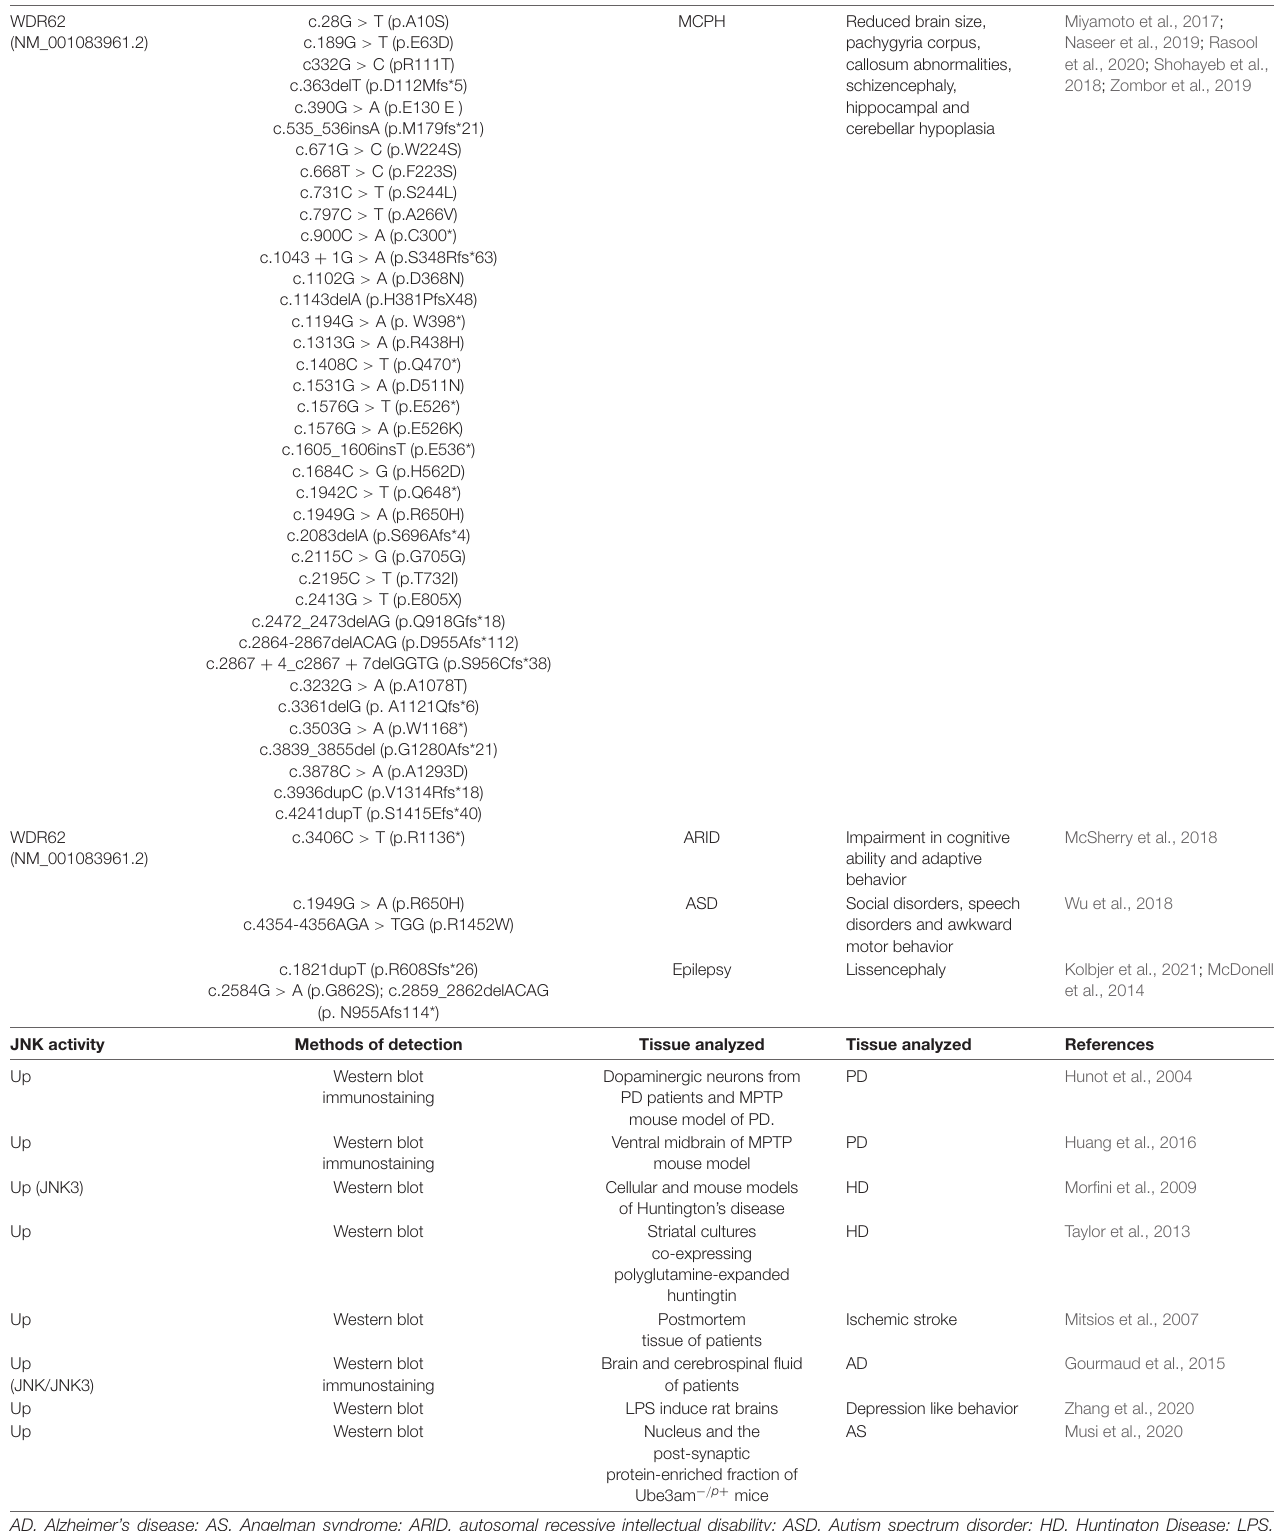
TABLE 1 | WDR62 and JNK signaling in neurological disorders. Gene Mutations Types of